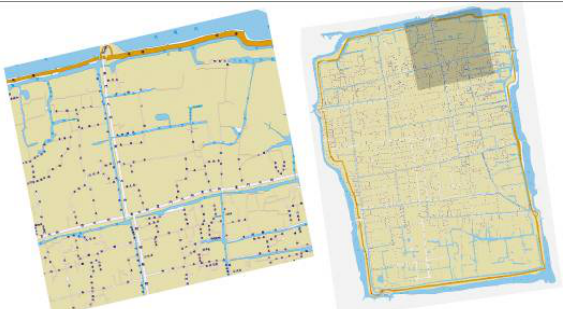
Figure 8 ． Same part from the map of 1930’s. Showing waterways in irregular shapes, widths and directions